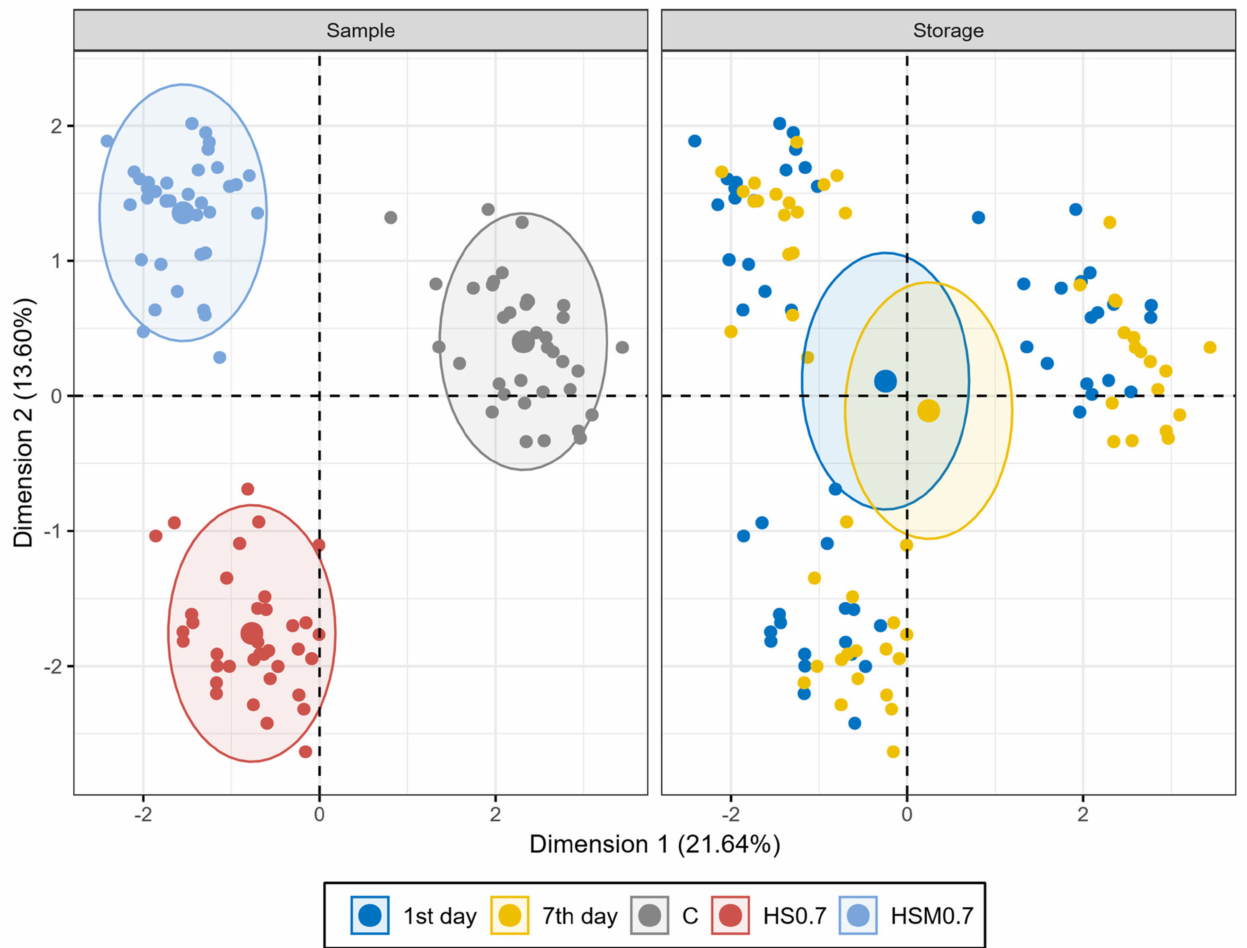
Figure 2. Multiple factor analysis (MFA) plot of breast meat samples: Combined graph of individuals with visualised sample and storage factor. C: control group; HS0.7: broilers’ diet supplemented with 0.7% of dietary natural HS; and HSA0.7: broilers’ diet supplemented with 0.7% of HS acidified with formic